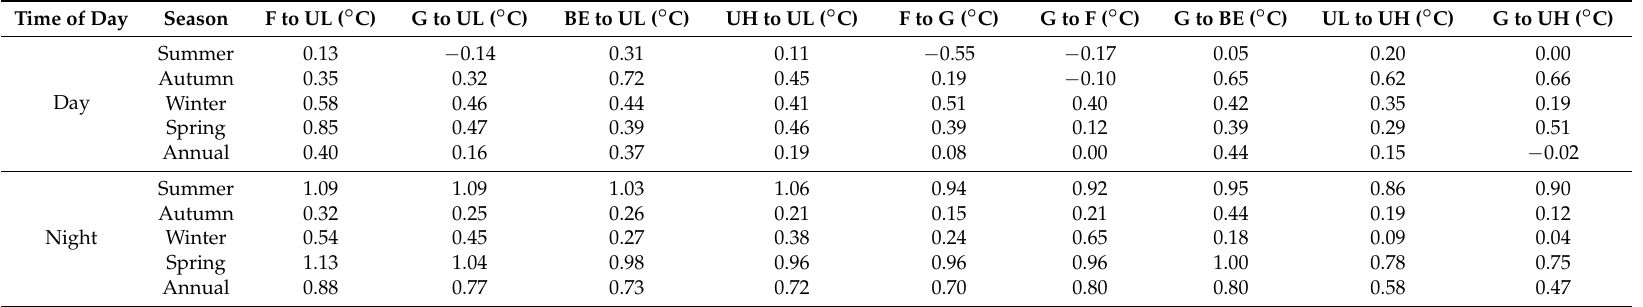
Table 2. Average land cover associated LST change between 2003 and 2013 for the greatest land cover change within a MODIS pixel and the change to land cover that dominates the pixel (>50%). Classes are represented as: Bare Earth (BE), Grassland (G), Forest (F), Low Urban albedo (UL) and High Urban albedo (UH). Time of